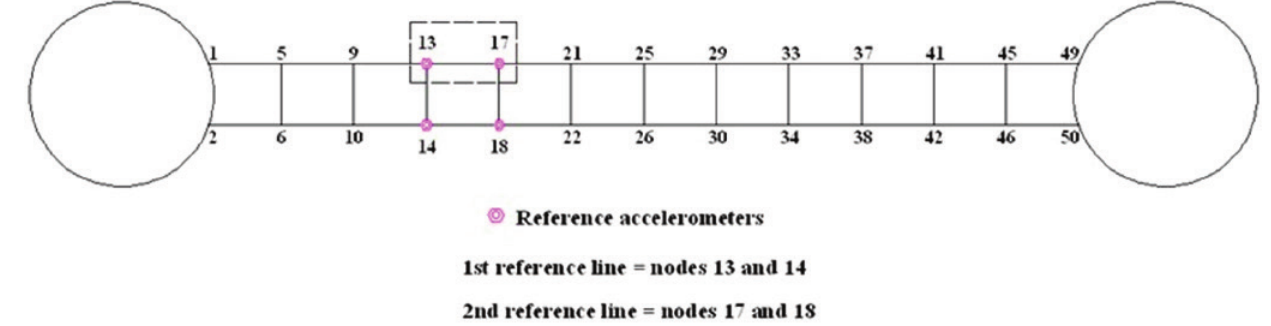
Scheme of the horizontal span tested on instrumented points (modified from Brasiliano et al.